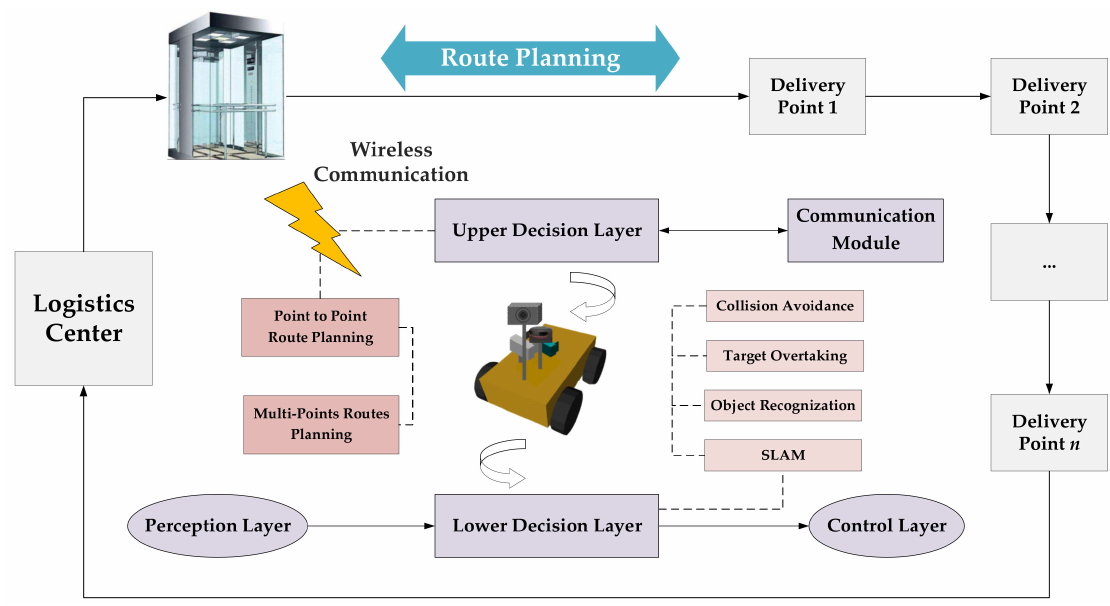
Figure 1. The system structure of the wheeled autonomous actuator of logistics